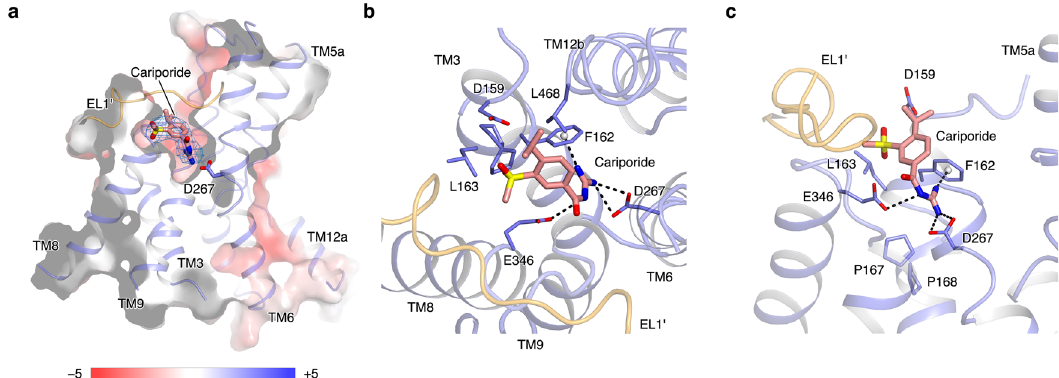
Fig. 4 Cariporide binding pocket of the NHE1-CHP1 K/cariporide complex. a . Slice-through electrostatic surface of the NHE1-CHP1 K/cariporide complex. The cariporide molecule is displayed in sticks, and its corresponding EM density is shown in mesh. b , c Binding site of the inhibitor cariporide. The cariporide molecule (salmon) and its surrounding residues are shown as stick models. Two subunits of NHE1 are colored in orange